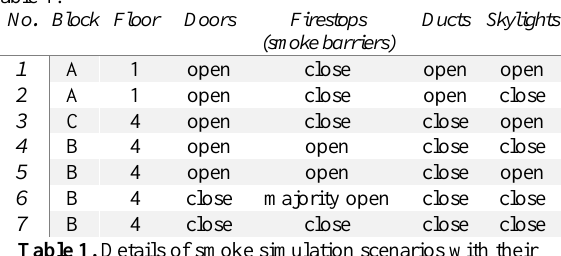
Table 1. Details of smoke simulation scenarios with their central emission